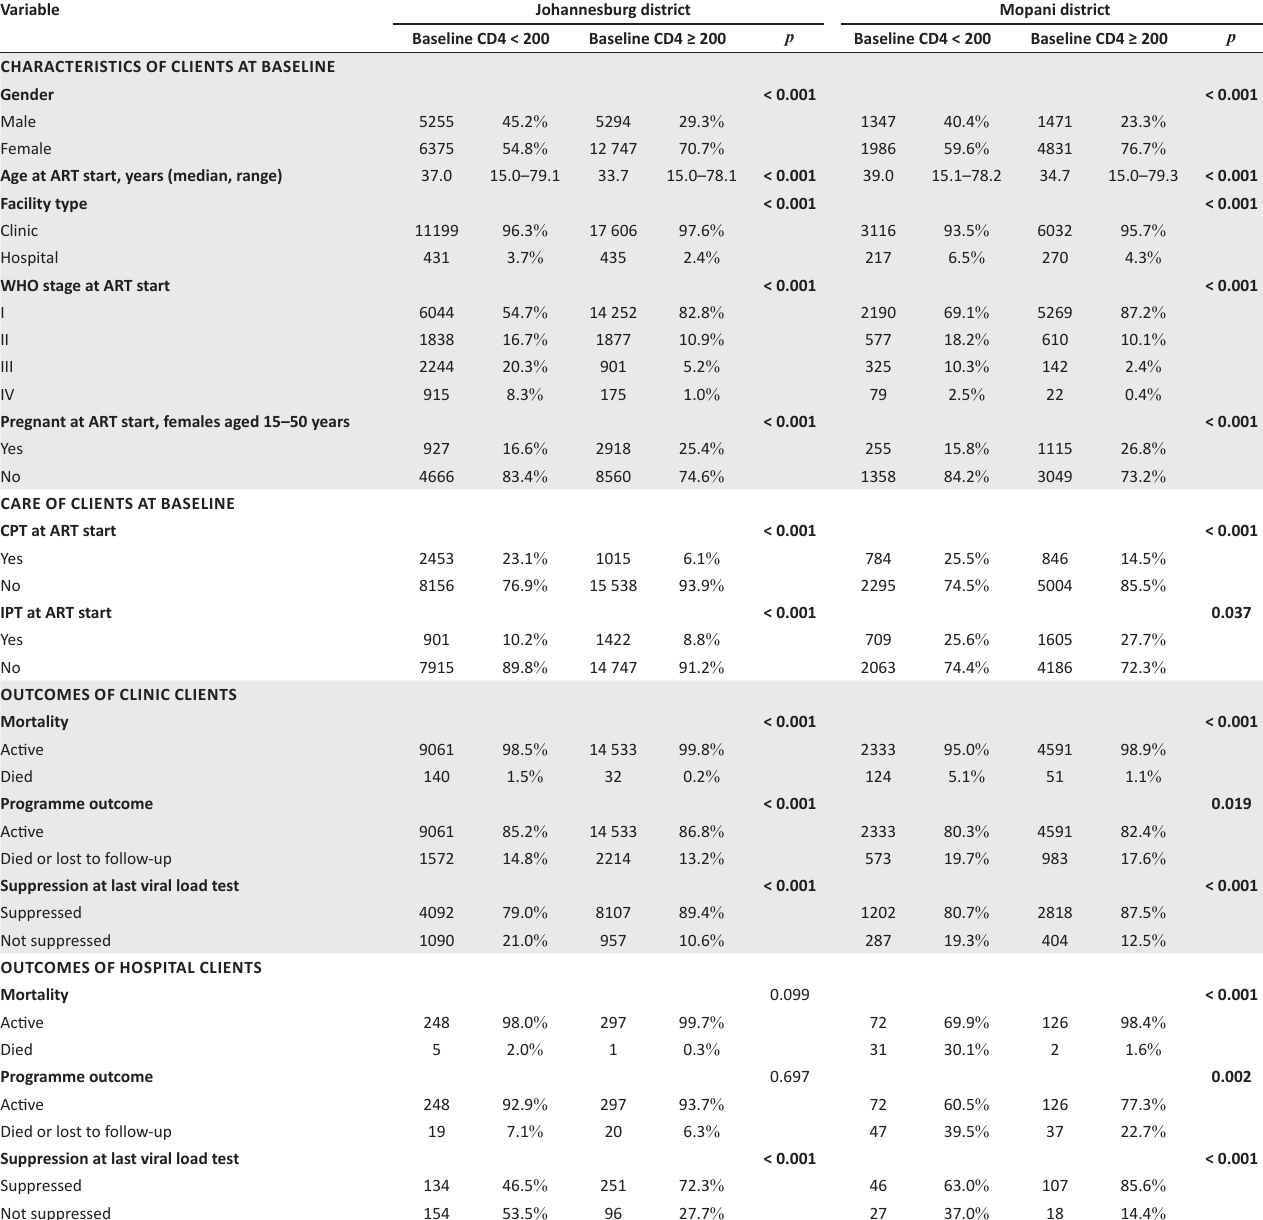
TABLE 2: Characteristics, care and outcomes of adult clients initiating antiretroviral therapy in 2017 by baseline CD4 count.